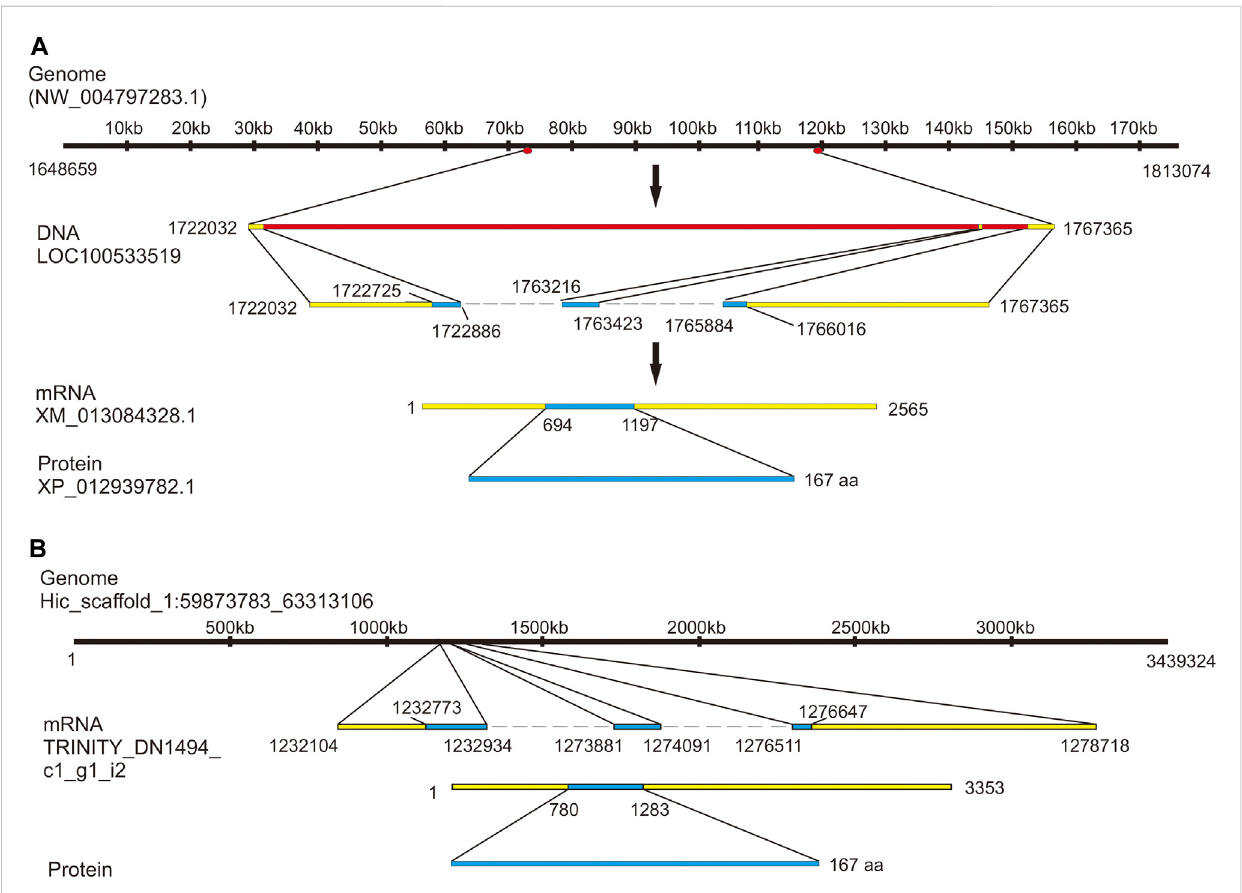
Gene expression mapping of the Aplysia vasotcin (apVT) precursor. (A) A genome sequence from NCBI (NW_004797283.1) expresses one gene: LOC100533519 (product: Lys-conopressin preprohormone as named in NCBI). The gene corresponds to a mRNA (XM_013084328.1, with two introns: one between 1722886 bp to 1763216 bp and the other between 1763423 bp to 1765884 bp), which produces a protein (XP_012939782.1): Lys- conopressin preprohormone isoform X1. (B) Genome Hic_scaffold_1:59873783_63313106 from the Aplysia gene nucleotide database (the